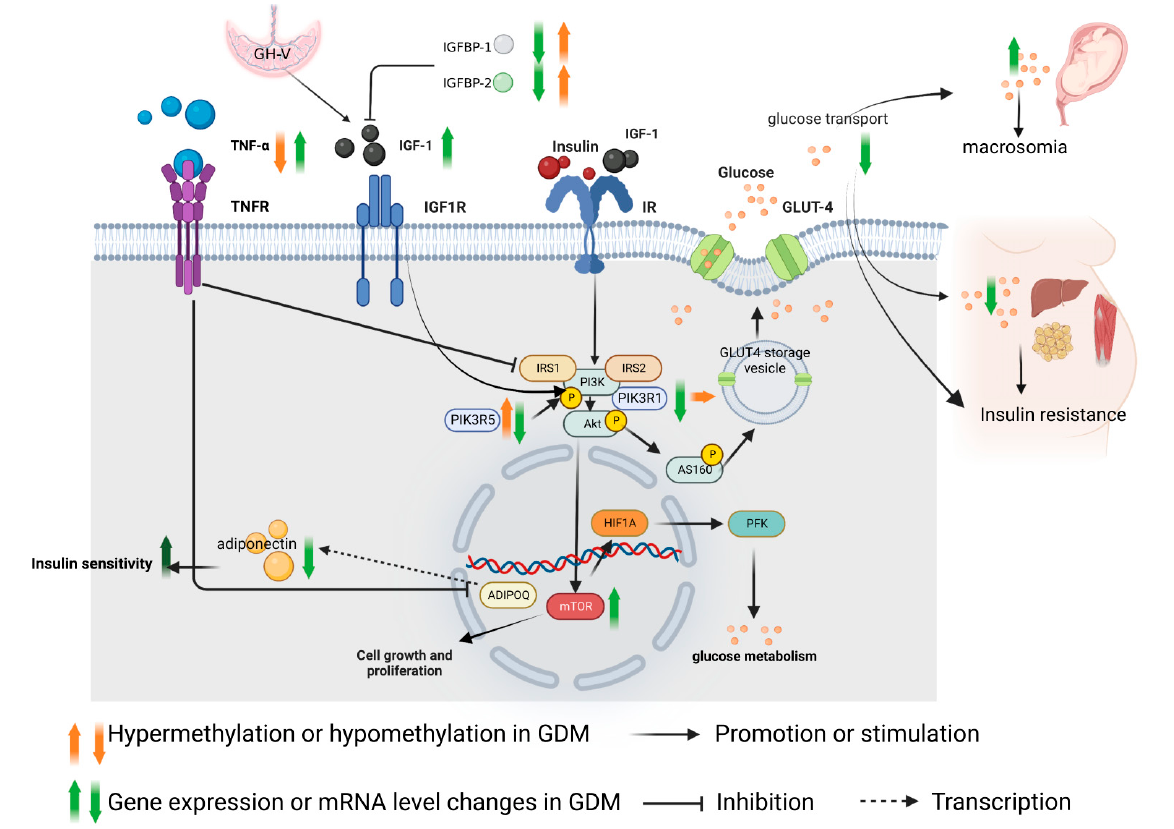
Figure 2. Changes of IGF-1 axis, insulin related cellular signal transduction pathway and methylation of related molecules in GDM. The images in this figure were taken from https://biorender.com/(accessed on 22 November 2022).